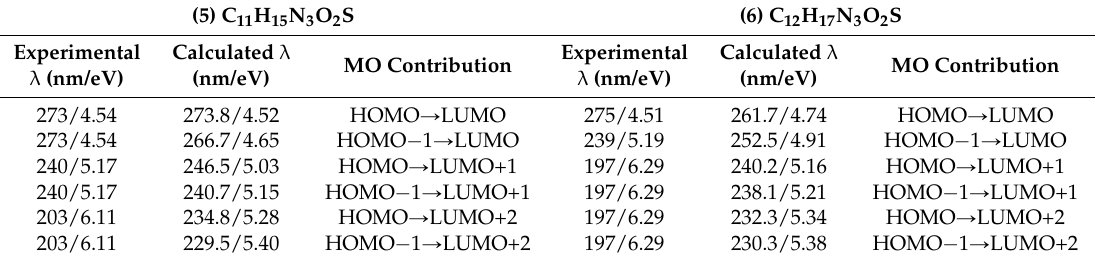
Figure 9. Calculated frontier molecular orbitals for C 11 H 15 N 3 O 2 S ( 5 ) and C 12 H 17 N 3 O 2 S ( 6 ). Table 9. Experimental and calculated energy of molecular orbitals of ( 5 ) and ( 6 ) and associated transitions.